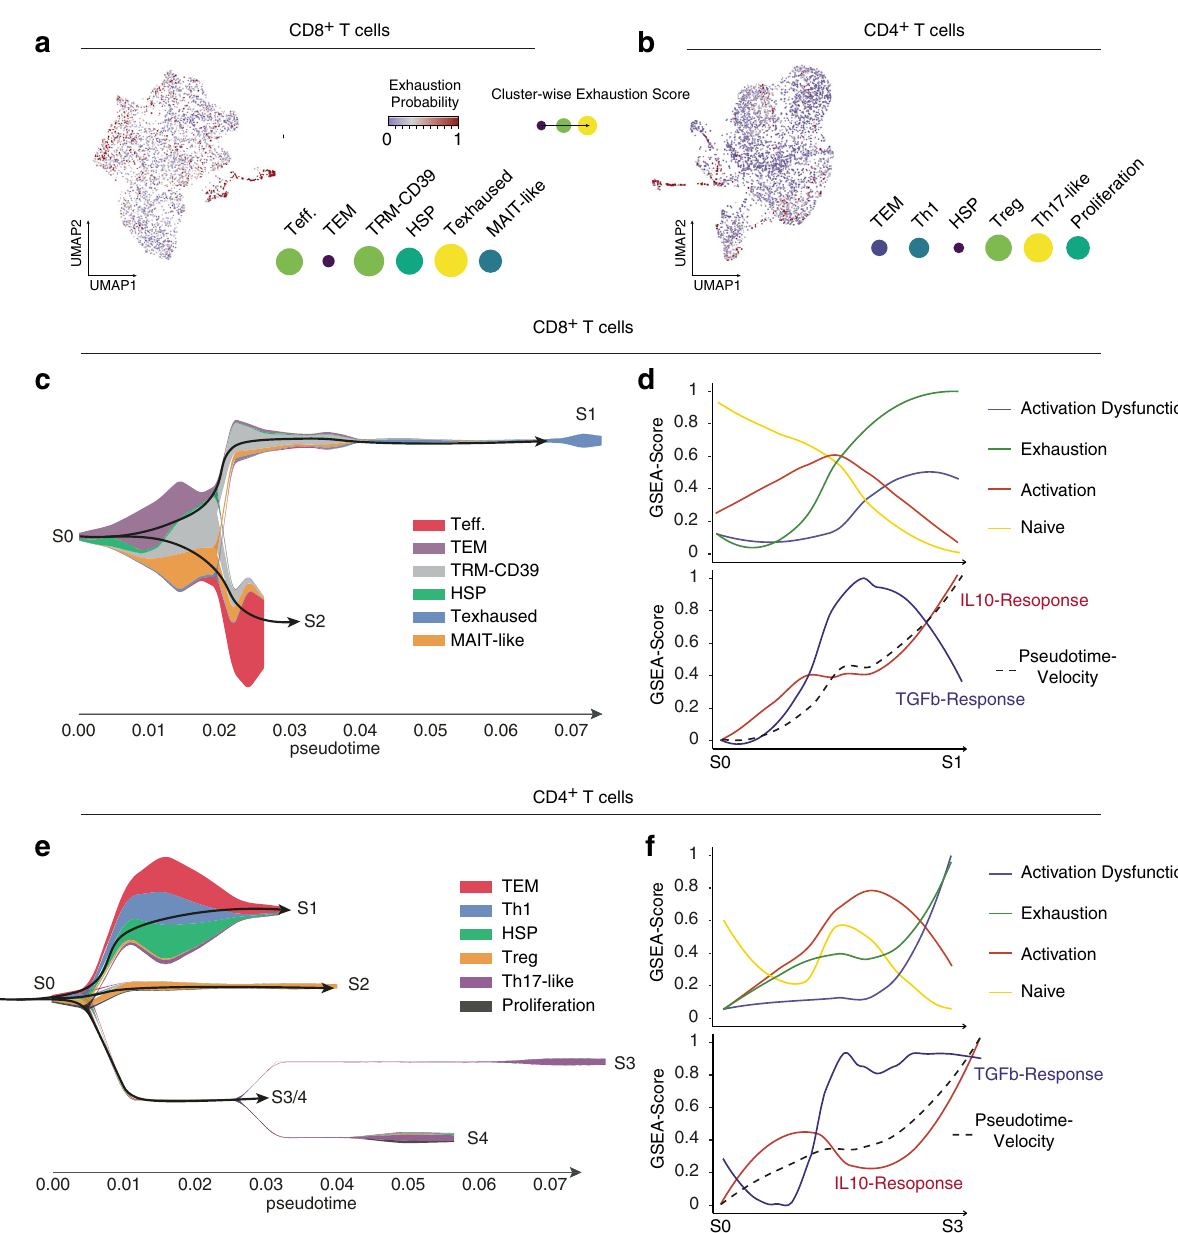
Pseudotime- Velocity